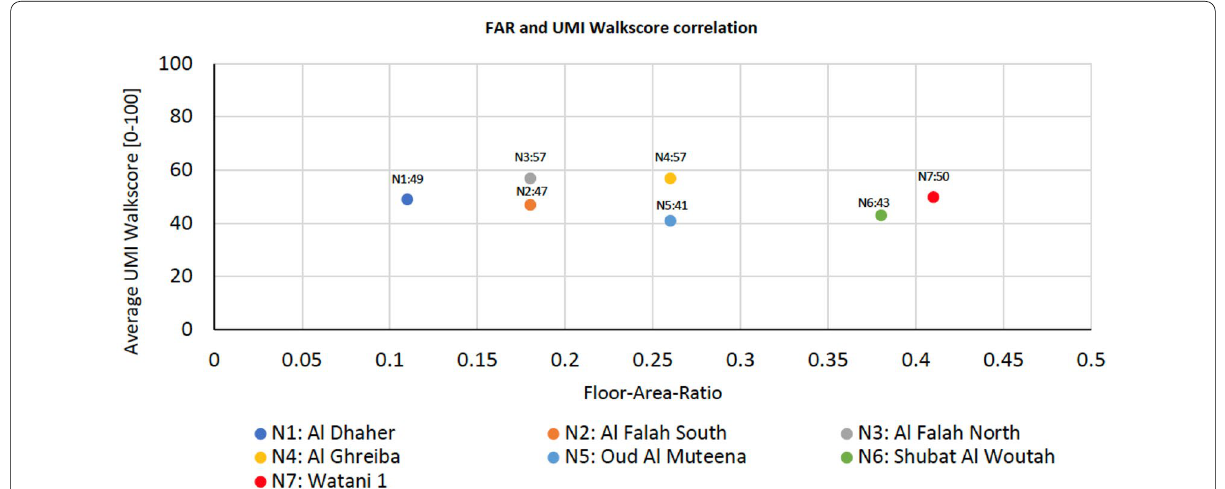
Fig. 8 Correlation results between the urban compactness ratio (FAR) of the case studies vs their simulated UMI